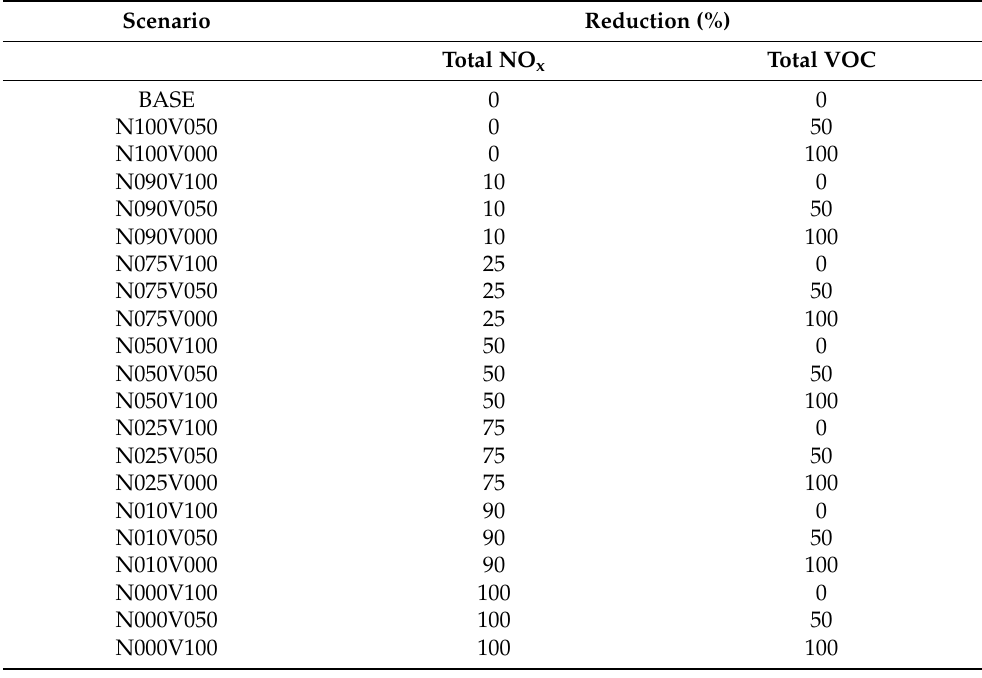
Table 1. Simulated scenarios with the applied reductions in the nitrogen oxide (NO x ) and volatile organic compound (VOC)